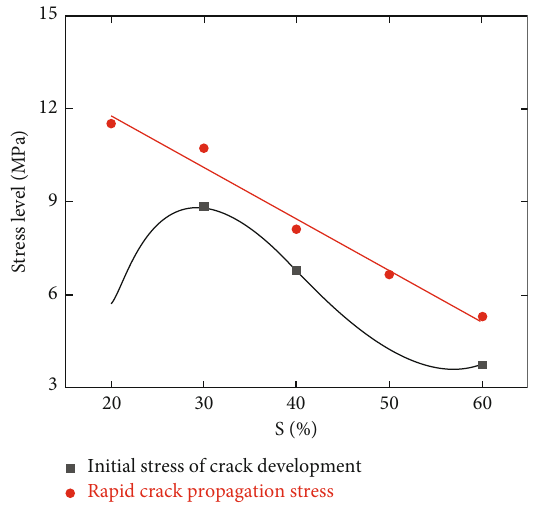
Figure 13: Variation of initial stress of crack development and rapid crack propagation